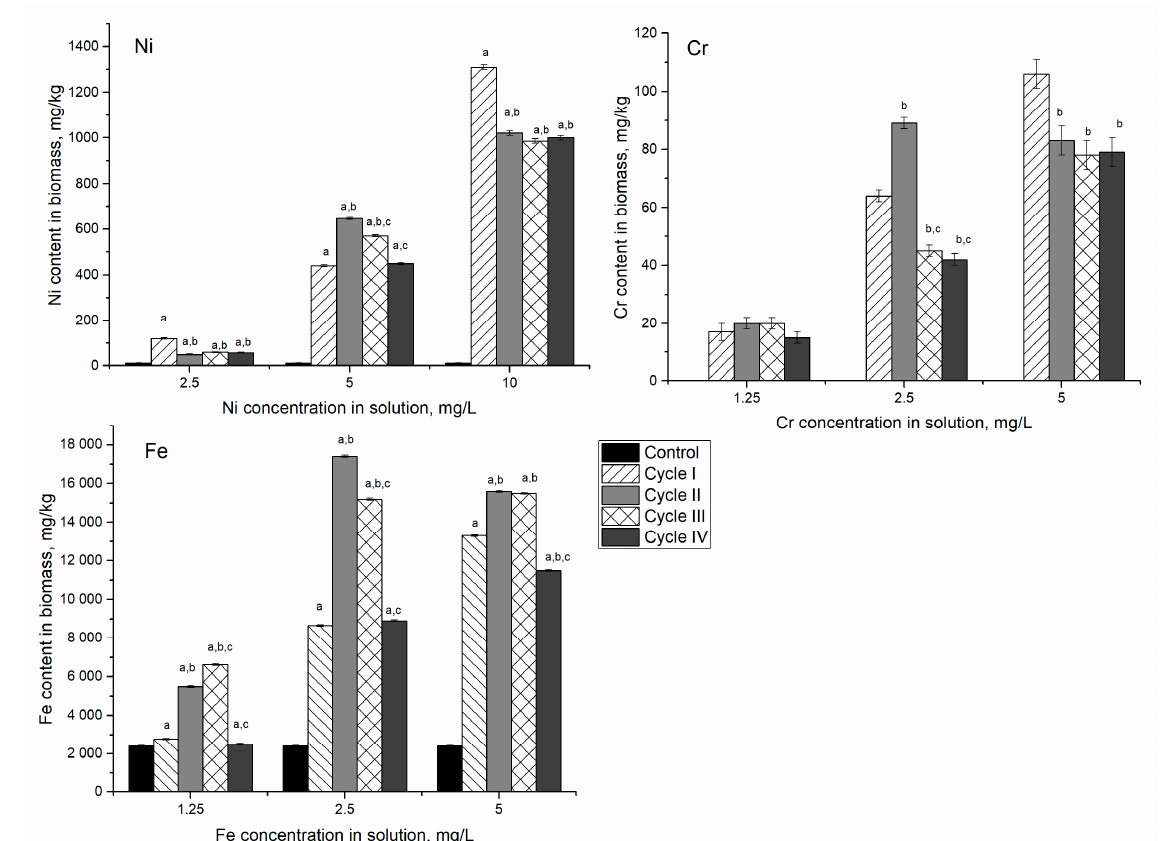
Figure 4. Accumulation of metal ions in spirulina biomass during its repeated cultivation in the medium containing metal ions at concentrations: nickel 2.5–10 mg/L, chromium and iron 1.25–5 mg/L. a: p < 0.001 for the difference between experimental and control samples; b: p < 0.001 for the difference from the first cycle; c: p < 0.001 for the difference from the second cycle.